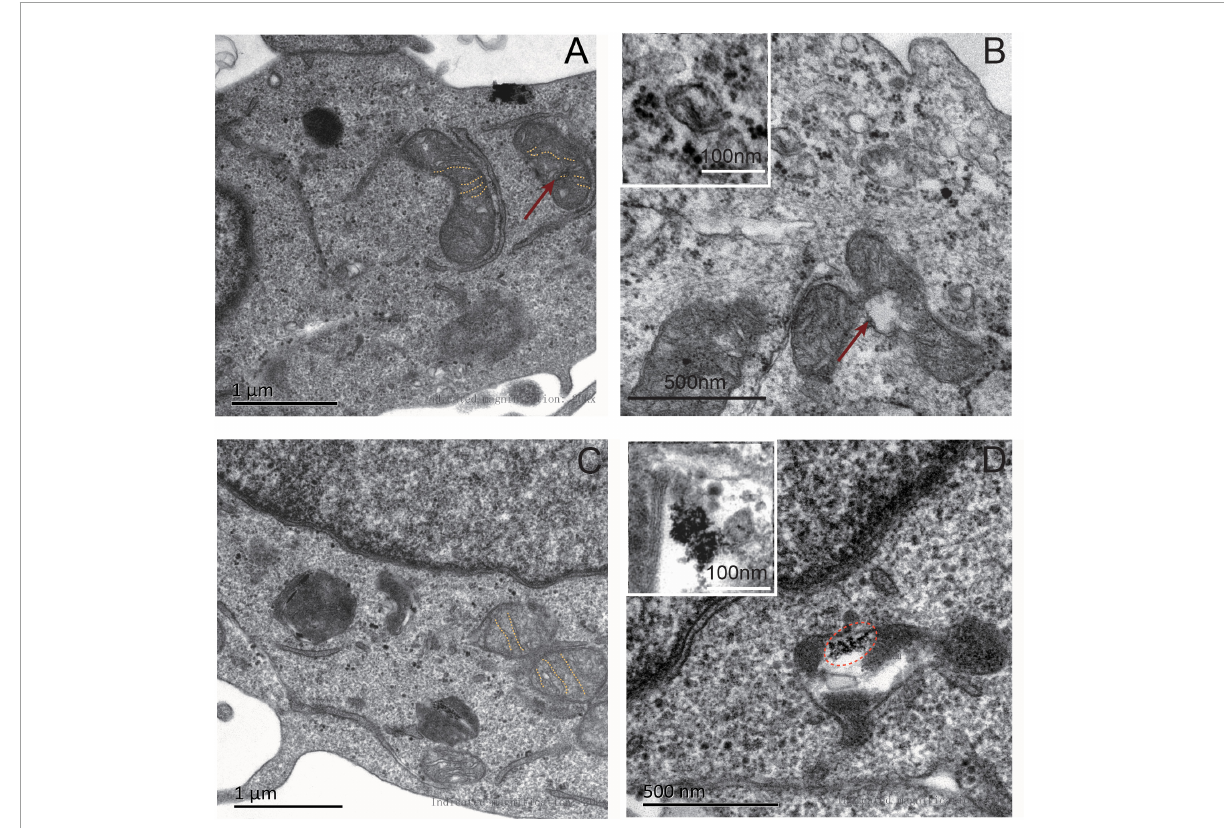
FIGURE3 Transmission scanning electron microscopy (TEM) of NSCs under the condition of iron overloading (320 µ M). (A) Under the condition of iron overload, a large number of iron granules were endocytosed in neural stem cells. A large amount of iron deposited in the cytoplasm or near the plasma membrane of GFP-NSCs. (B) Mitochondrial membrane structure of GFP-NSCs exhibited damaged (red arrow marked). (C) However, the mitochondria within with mms6 -GPF-NSCs did not exhibit serious damage. (D) The iron particles in Mms6-GFP-NSCs could form a special crystalline in the cytoplasm [marked in the oval dotted box and displayed on the upper left panel of (D) ].